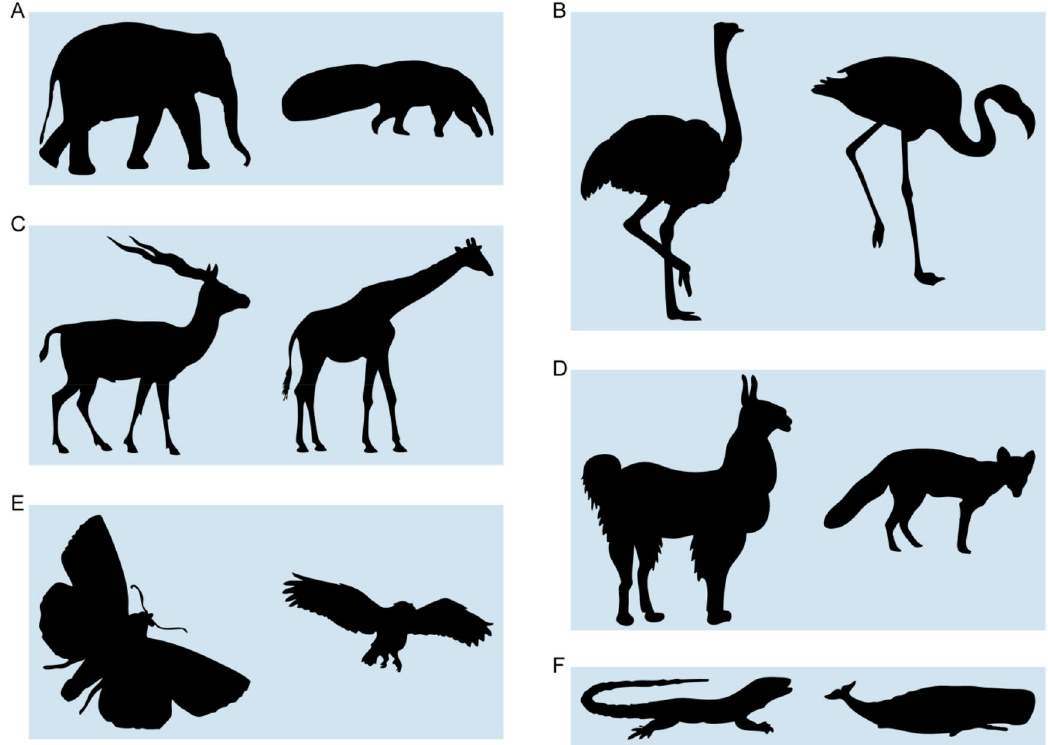
Figure 2. Stimuli of Experiment 1. Each pair was presented on the screen simultaneously, with the base shape to the left and the test shape to the right (arrangement the same as here in the figure). Images were obtained from different online databases and are reprinted with permission. ( A ) Elephant–Anteater (‘Elephant’ by depositphotos.com/bojanovic; ‘Anteater’ by depositphotos.com/160,377), ( B ) Ostrich–Flamingo (‘Ostrich’ by depositphotos.com/kaludov; ‘Flamingo’ by shutterstock/Yaroslavna Zemtsova), ( C ) Antelope–Giraffe (‘Antelope’ by shutterstock.com/Momo0607; ‘Giraffe’ by freedesignfile.com/Starder), ( D ) Lama–Fox (‘Lama’ by vecteezy.com; ‘Fox’ by shutterstock.com/Rey Kamensky), ( E ) Butterfly–Owl (‘Butterfly’ by shutterstock.com/ ntnt; ‘Owl’ by yayimages.com/Perysty), and ( F ) Lizard–Whale (‘Lizard’ by shutterstock.com/angelp; ‘Whale’ by depositphotos.com/ktinte). All stimuli are available at https ://doi.org/10.5281/zenod o.43042